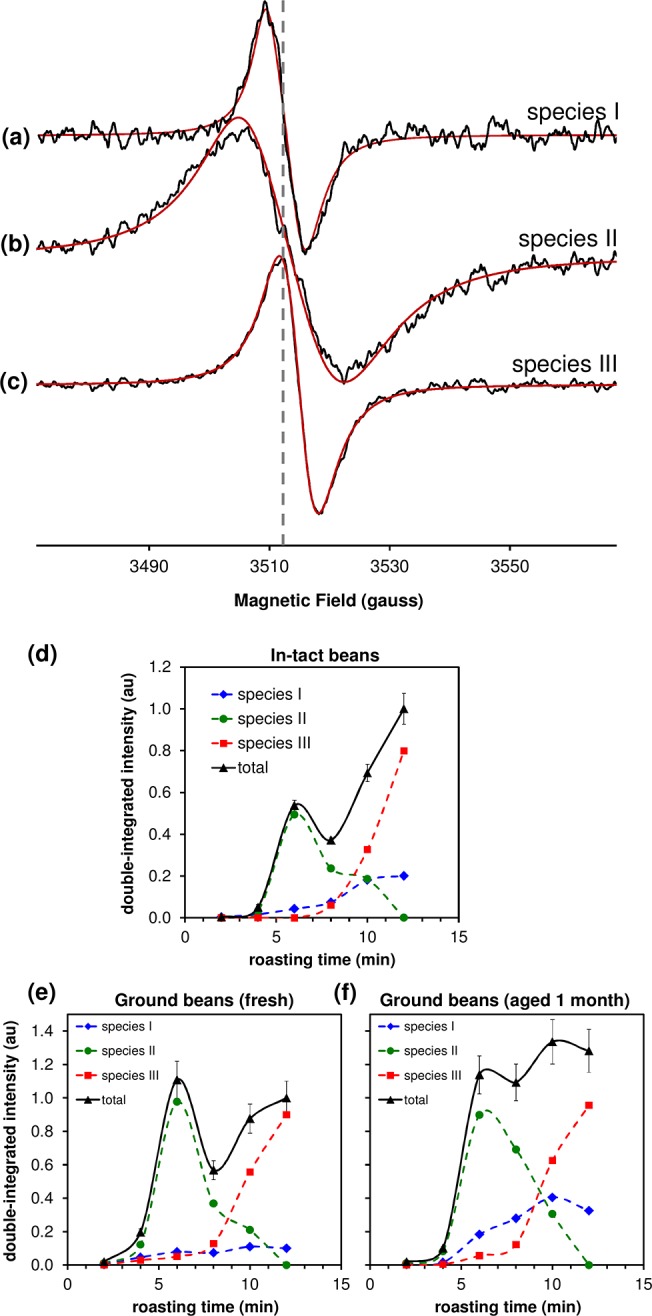
Multiple radical species are identified during roasting.
(a–c) Experimental (―) and simulated (―) EPR spectra of three putative radicals present in whole and ground coffee beans, isolated as shown in S4 Fig Using the basis spectra in a–c, the total EPR signal intensity (determined by double integration) of the experimental spectra from (d) in-tact beans, (e) freshly ground and (f) same grounds aged 1 month, was decomposed into contributions from species I–III. Details of the decompositions are shown in S5–S7 Figs The dashed vertical line in a–d is positioned at the line center of species I to aid comparison of the different spectra. Error bars in d represent the mean and standard error of the intensity of the EPR spectra from individual beans. Error bars in e-f depict an arbitrary ±10% error associated with EPR spectra from a single sample of ground beans. Note that the intensity in e-f is comparable, but the intensity in d is not directly comparable with e-f.